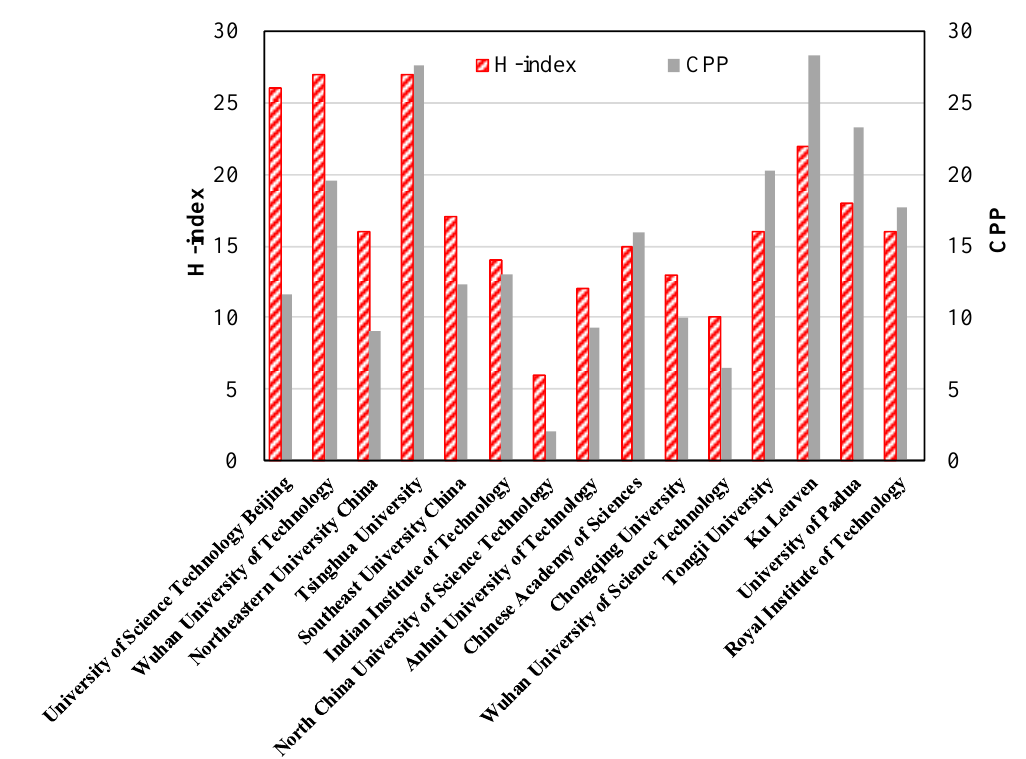
Figure 6. The H-index and CPP of the top 15 productive institutions.